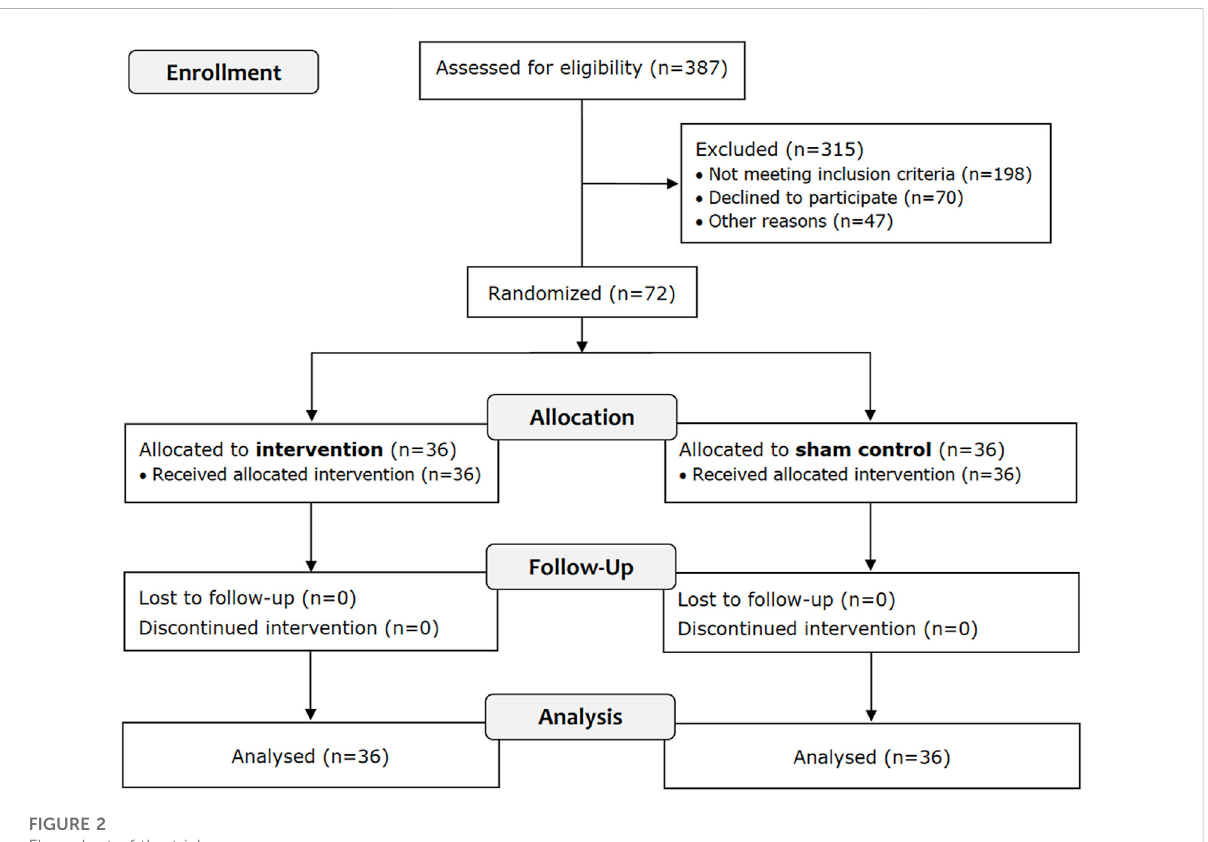
FIGURE 2 Flow chart of the